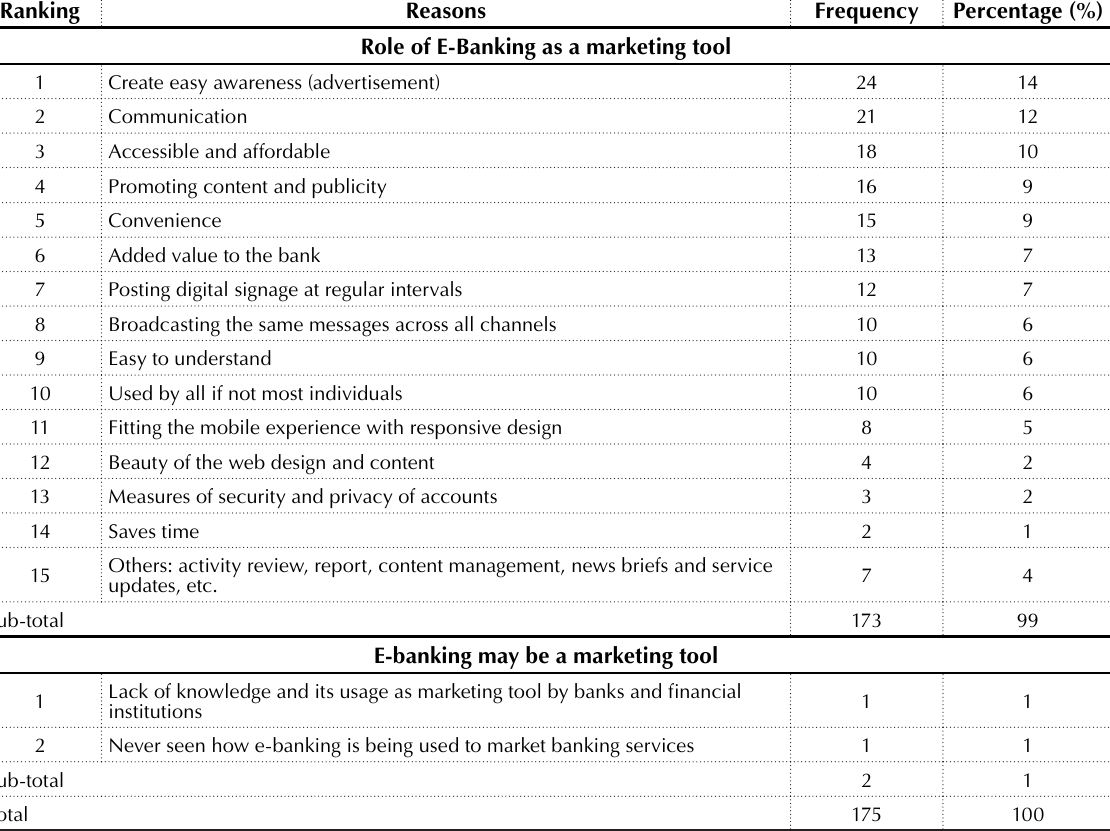
Table 3. Reasons to justify: can E-banking be used as a Marketing Tool?